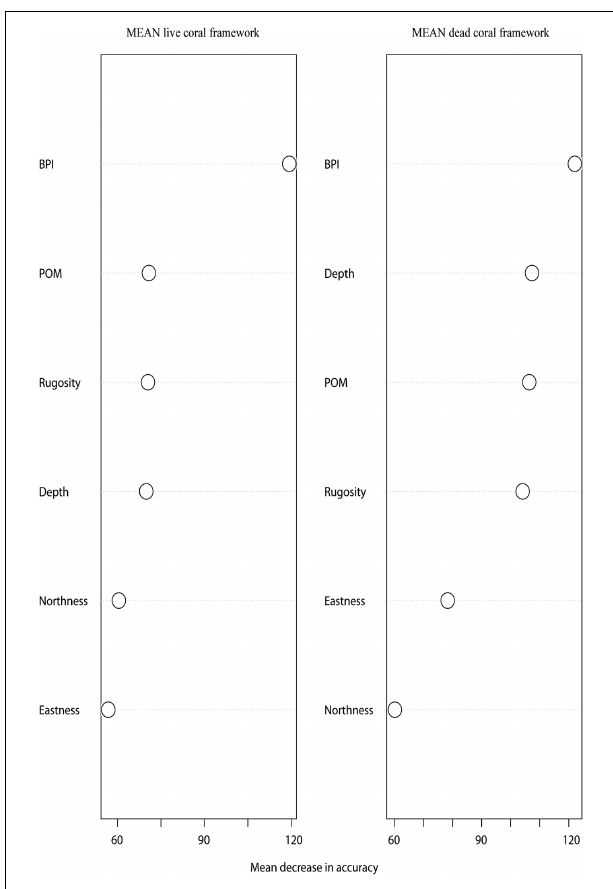
FIGURE 4 | Mean Decrease in Accuracy plots of the mean live and dead coral framework Random Forest model indicating what the contribution of each variable is to the model performance. When the Mean Decrease Accuracy value is higher for a certain variable, the removal of this variable from the model will decrease the model’s